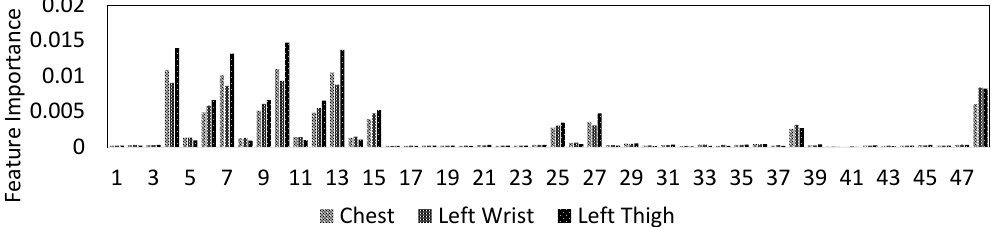
Figure 5. Importance of the extracted features from sensor data for lying posture